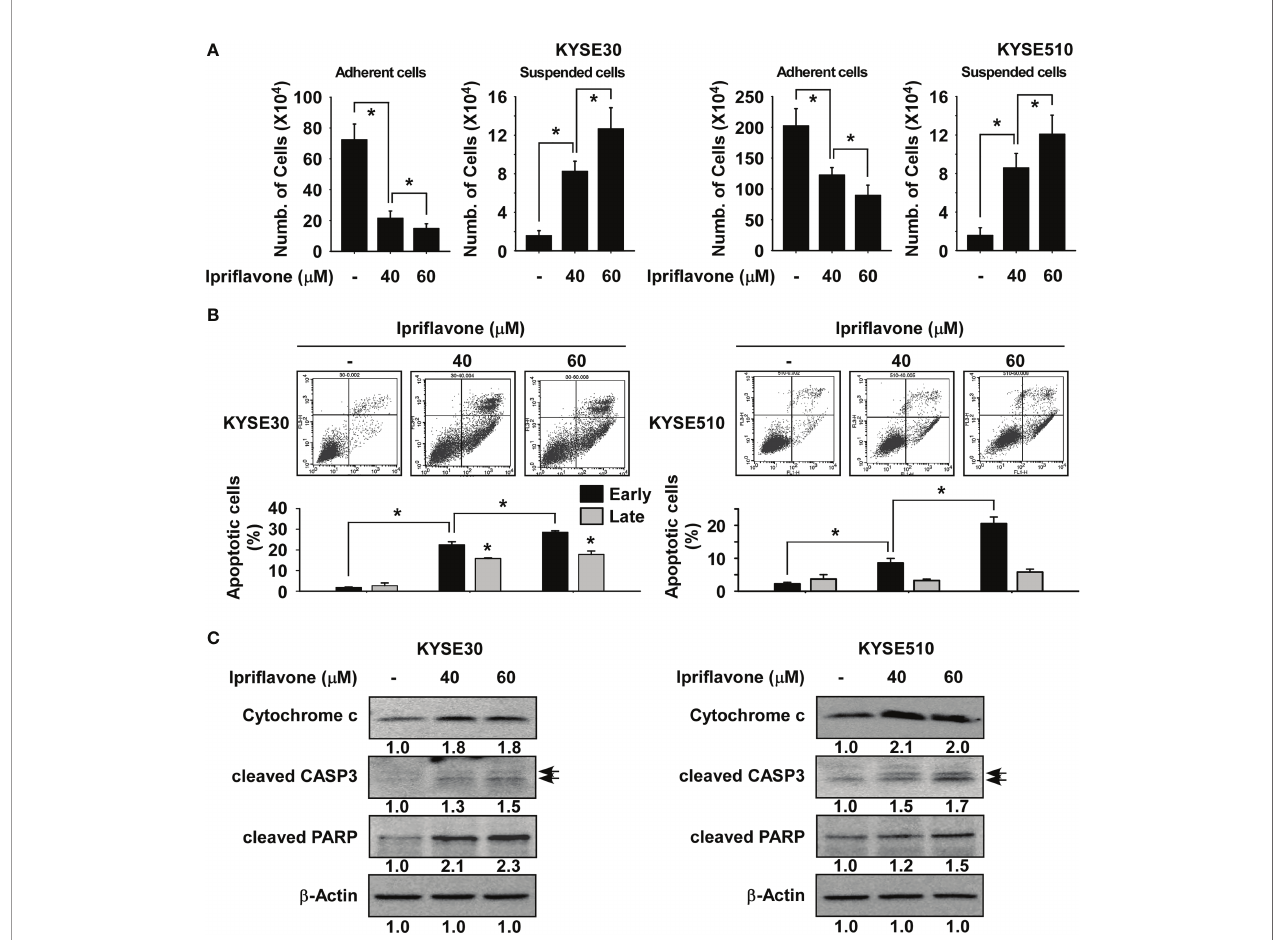
FIGURE 3 | Ipri fl avone induces apoptosis of ESCC cells. (A) Effect of Ipri fl avone on cell death. Cells were treated with Ipri fl avone for 72 h in 10% serum- supplemented medium. The number of suspended or attached cells was determined using a hematocytometer. (B) Effect of Ipri fl avone on cell apoptosis. Cells were treated with Ipri fl avone for 72 h in 10% serum-supplemented medium. Cells were stained with Annexin V and PI and then apoptosis was determined by FACS. For (A, B) data are shown as means ± S.D. of triplicate values from 3 independent experiments and the asterisk (*) indicates a signi fi cant ( p < 0.05) difference. (C) Effect of Ipri fl avone on apoptosis marker proteins. The expression of cytochrome c, cleaved CASP3 and cleaved PARP was determined by Western blotting. Similar results were obtained from three independent experiments and band density was measured using the Image J (NIH) software